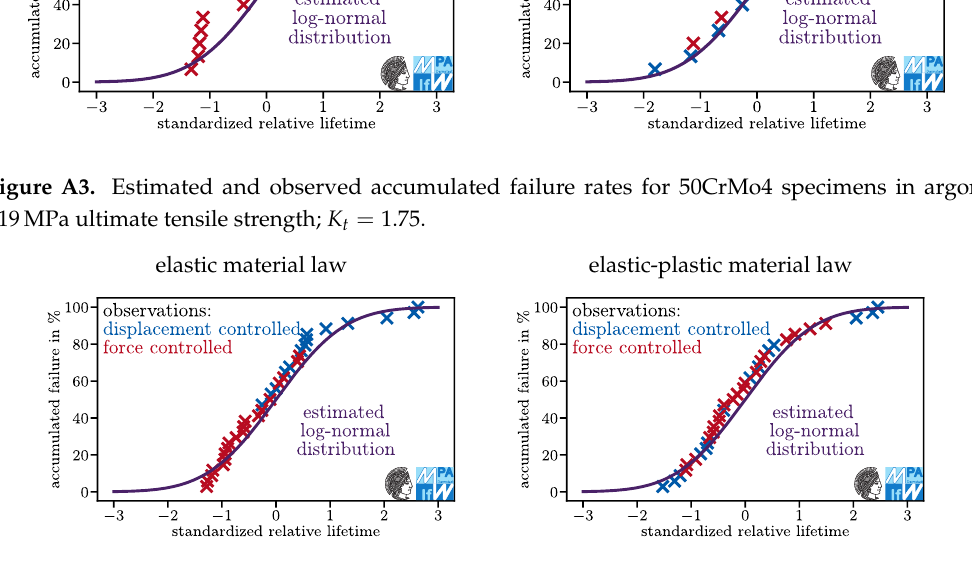
Figure A4. Estimated and observed accumulated failure rates for 50CrMo4 specimens in laboratory air; 919MPa ultimate tensile strength; K t = 2.06.